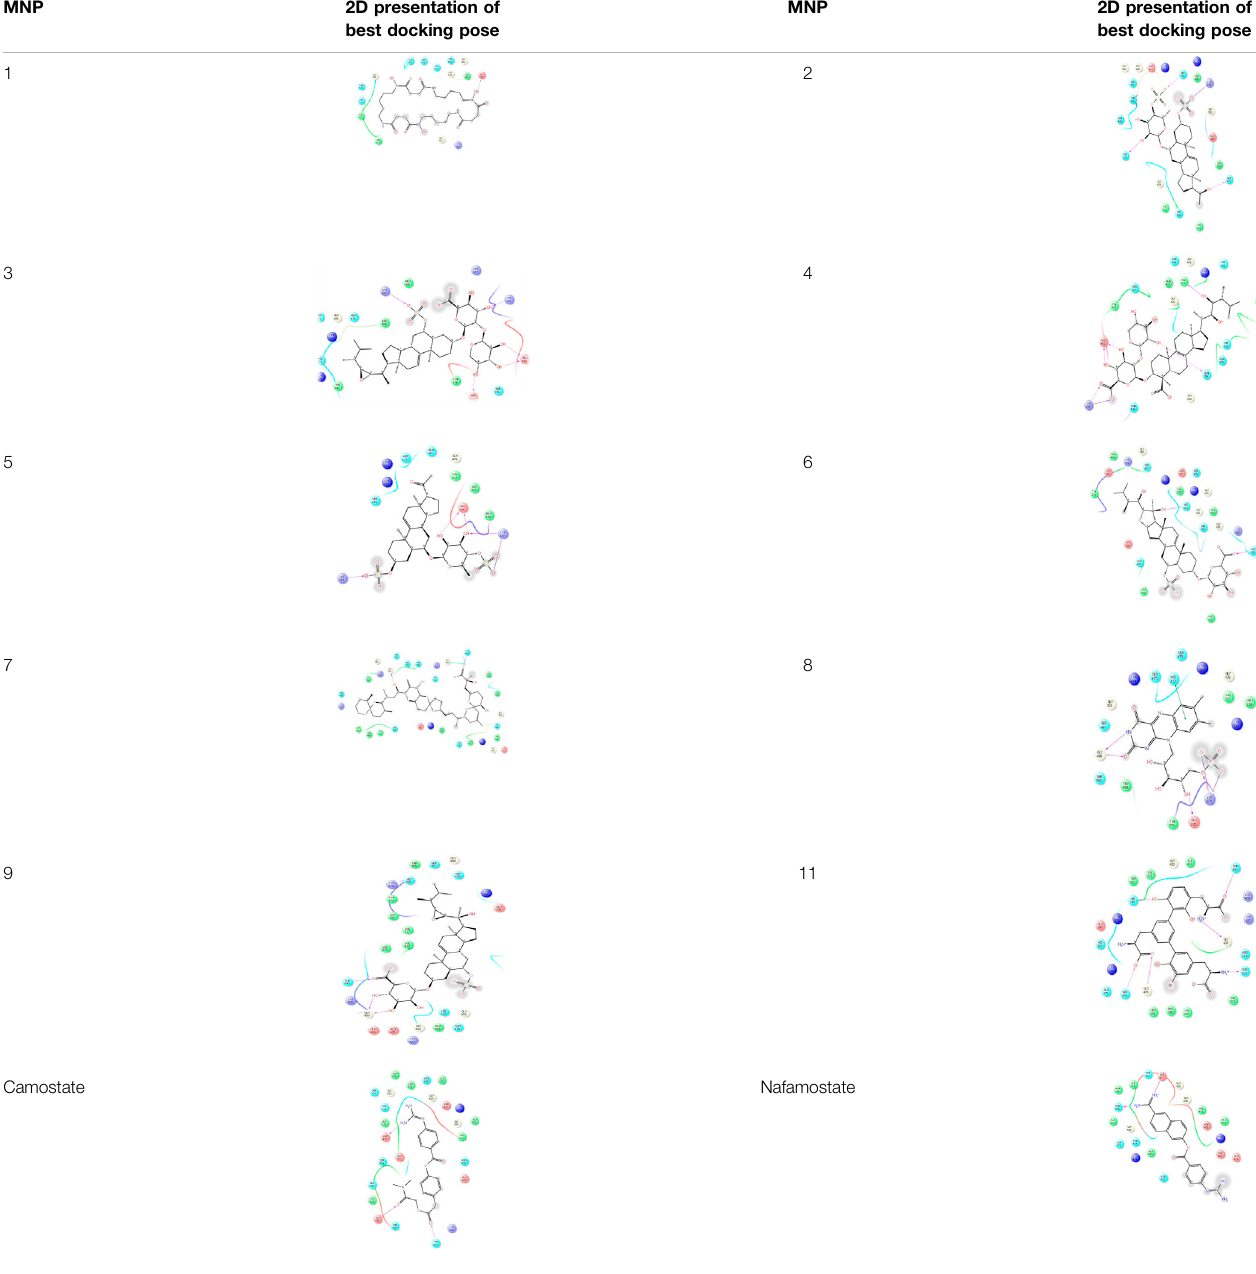
TABLE 5 | 2D presentation of best Glide docking pose at the catalytic domain of TMPRSS2 for investigated marine natural product. MNP 2D presentation of MNP 2D presentation of best docking pose best docking